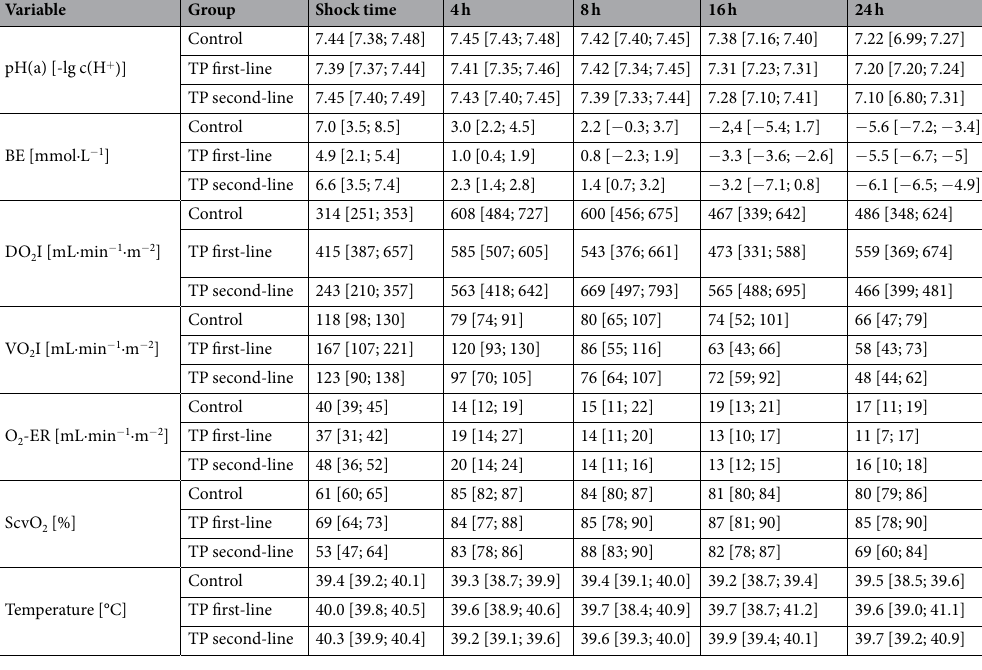
Table 2. Metabolism, oxygenation and temperature of the study groups during the 24-hour interventional period. Values are presented as median [interquartile range]. BE, base excess; DO 2 I, oxygen delivery index; O 2 -ER, oxygen extraction rate; pH(a), arterial potentia hydrogenii; S cv O 2 , central venous oxygen saturation; TP, Terlipressin; VO 2 I, oxygen consumption index